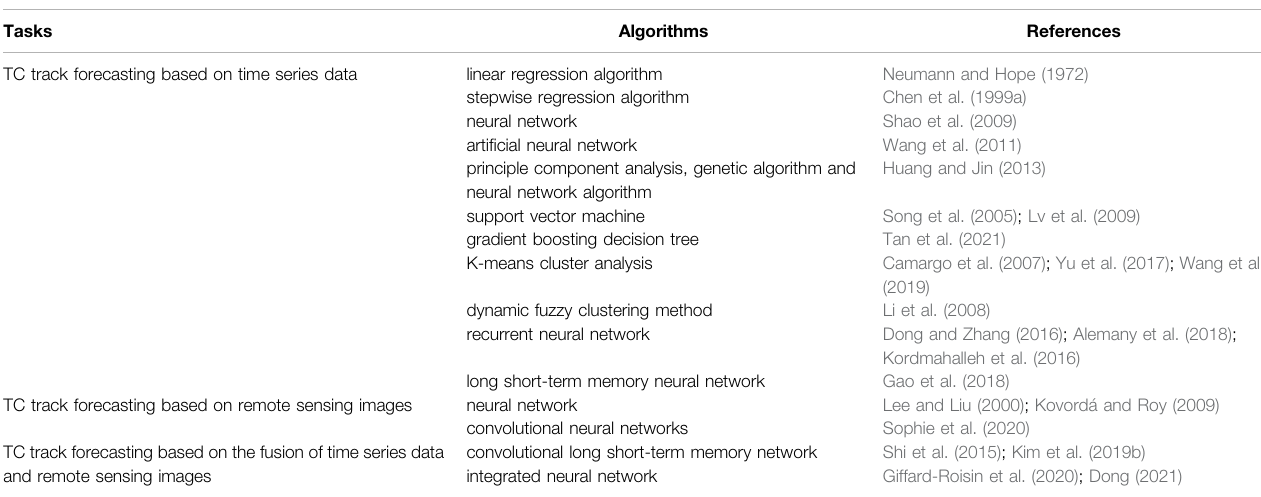
TABLE 2 | Machine learning algorithms used in TC track